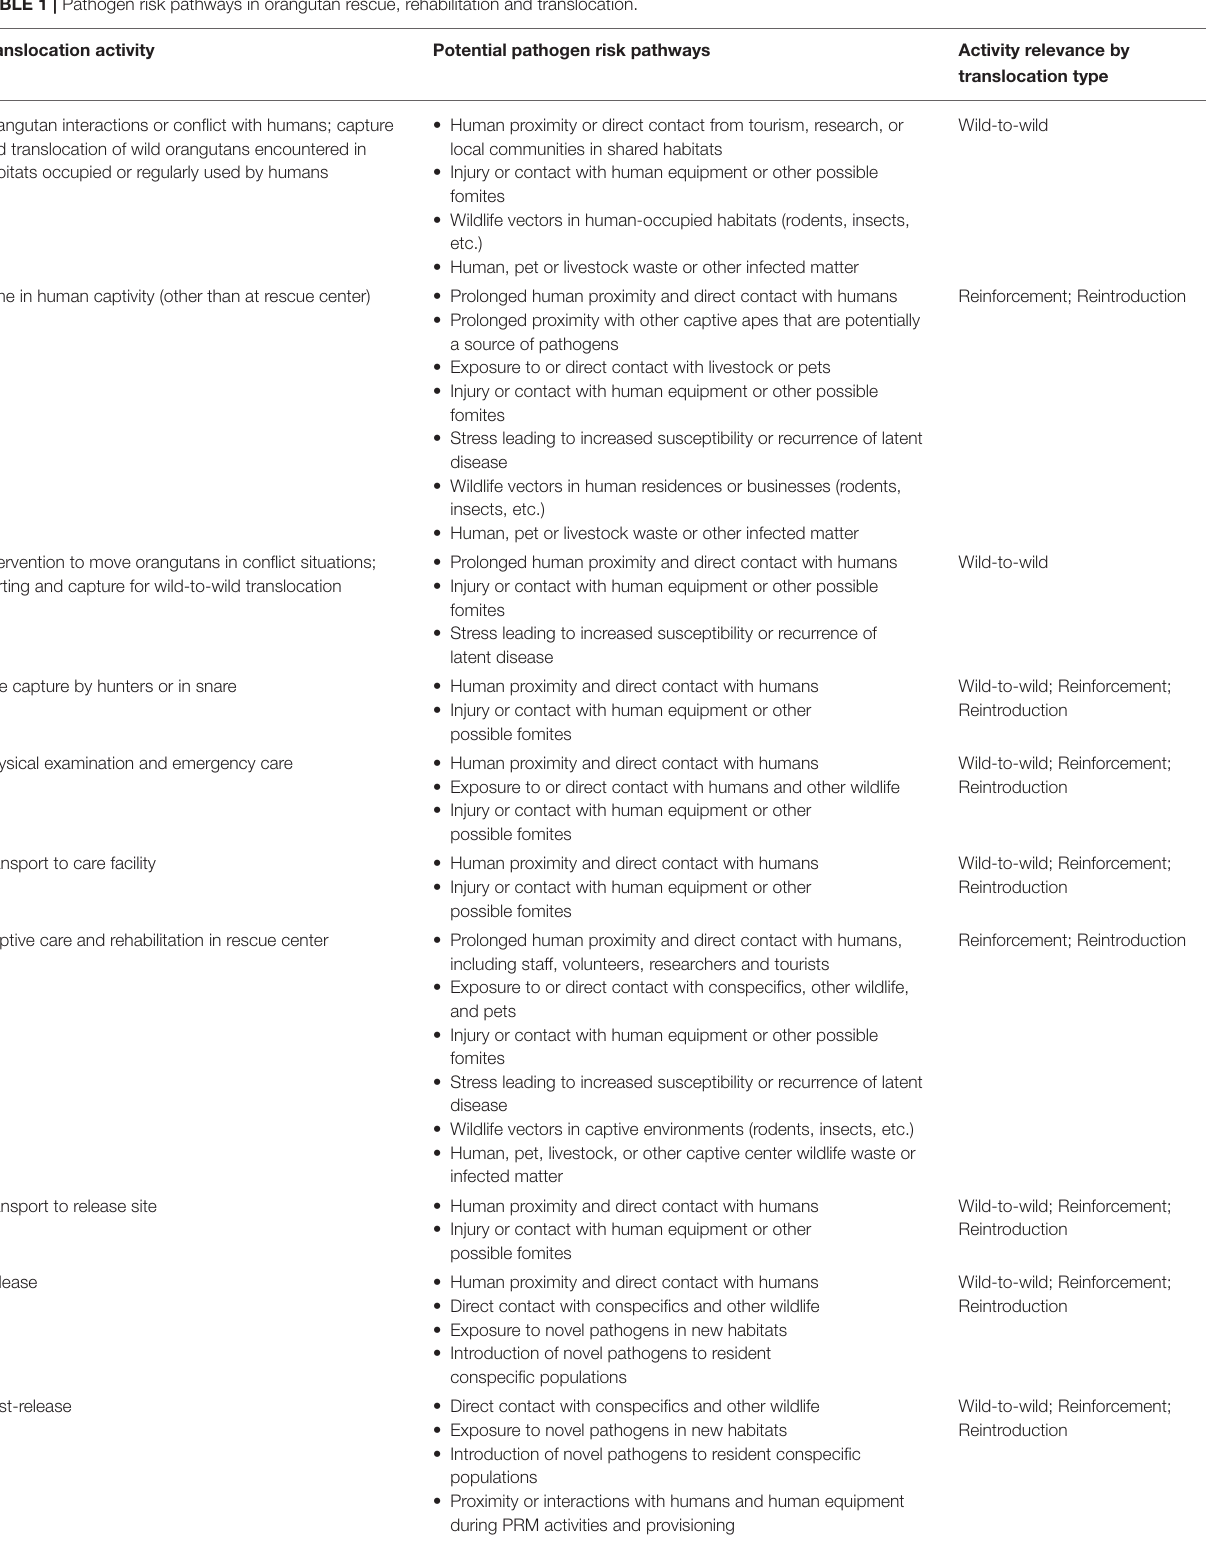
TABLE 1 | Pathogen risk pathways in orangutan rescue, rehabilitation and